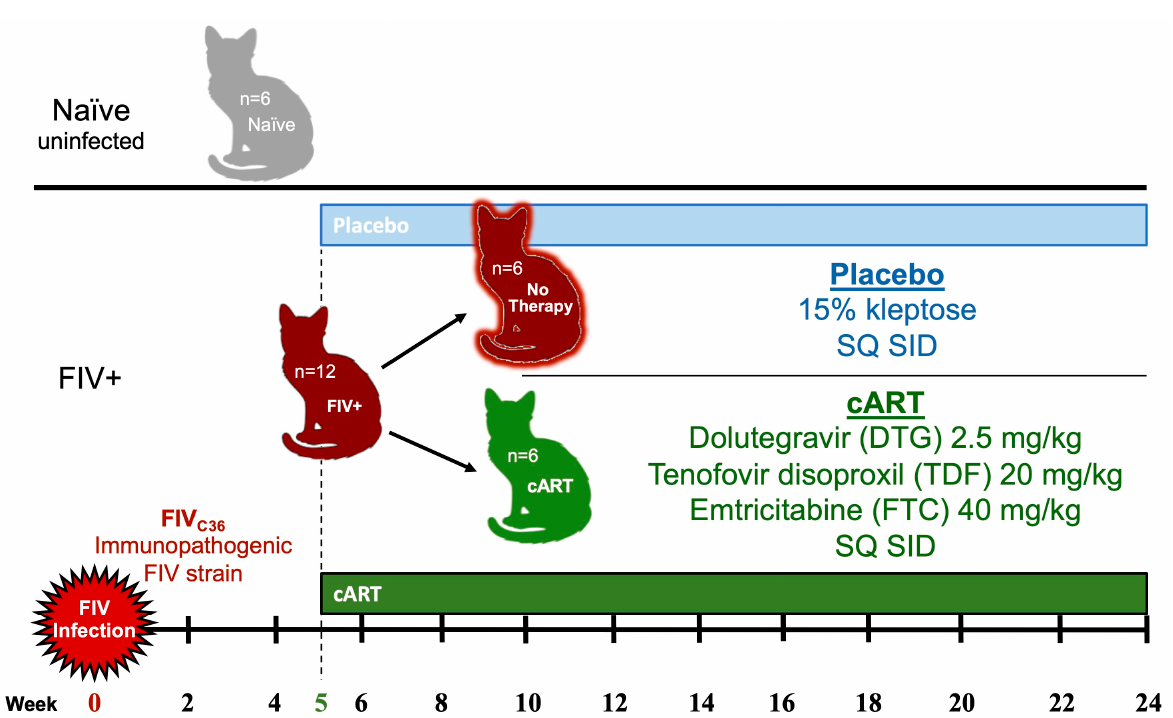
Figure 1. Distribution of cats and treatment assignments. Eighteen cats were randomly distributed across three groups, equally containing female-intact and male-neutered cats. At day 0, twelve cats were inoculated with FIV C36 and one group ( n = 6) was treated daily with cART starting at week 5, while the other group ( n = 6) received placebo. The remaining were naïve uninfected control cats ( n = 6).